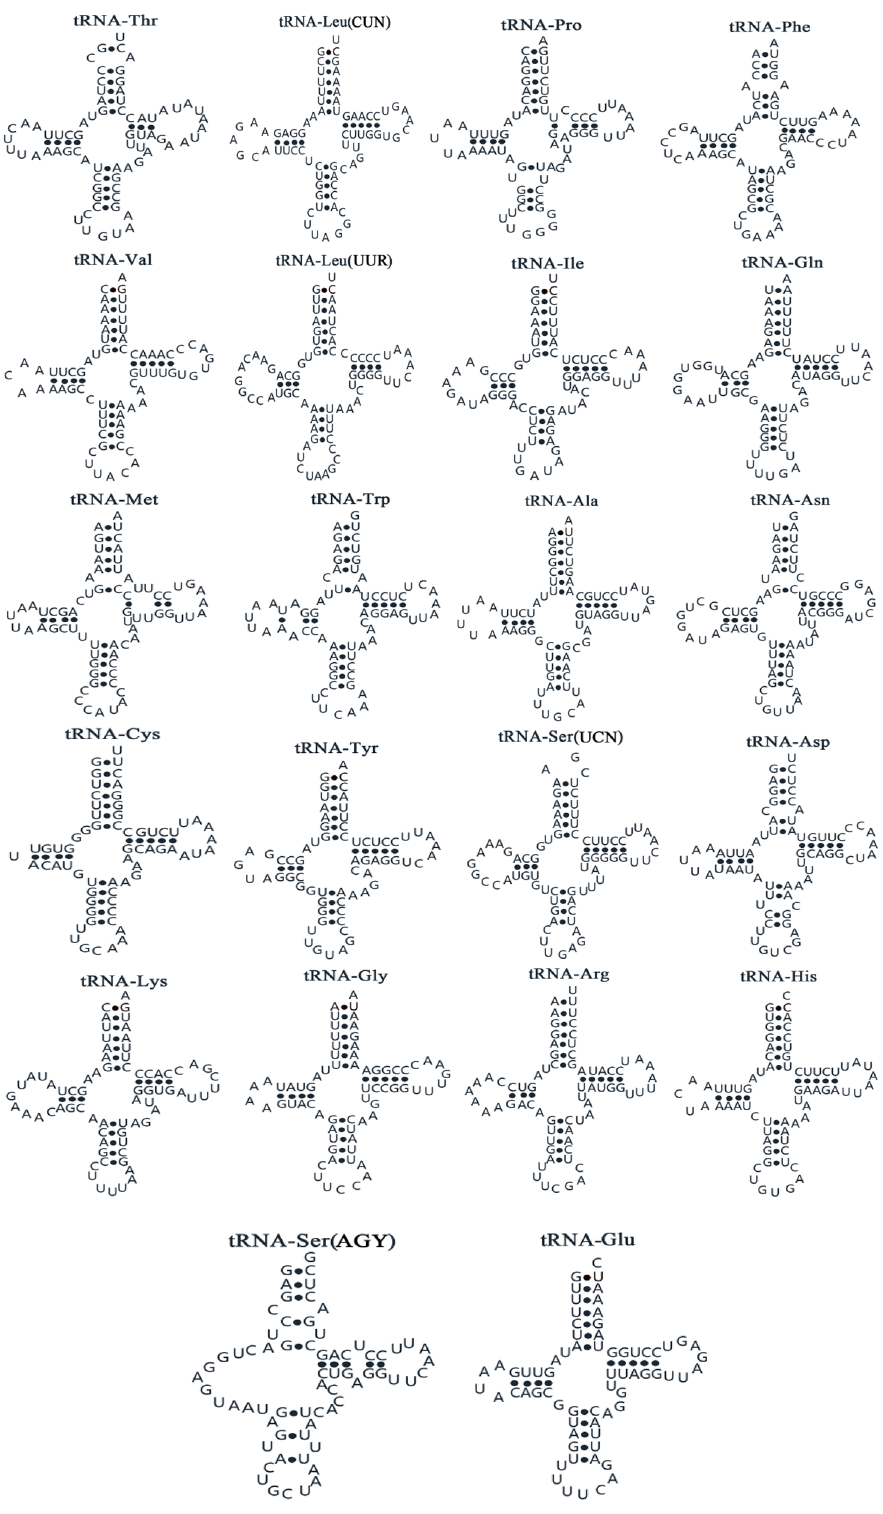
Figure 3. Putative tRNA secondary structures found mitochondrial genome of Rhacophorus